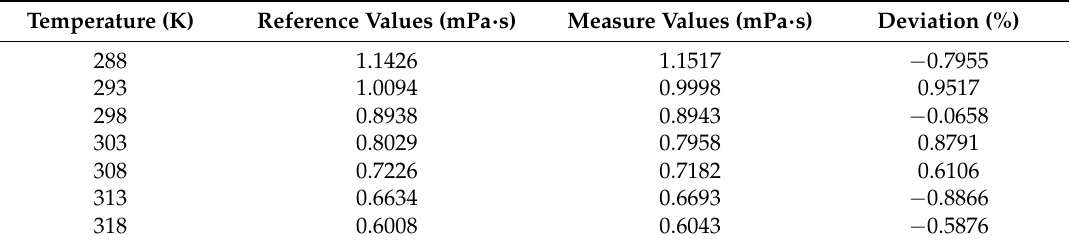
Table 2. Viscosity measurement and analysis for water.